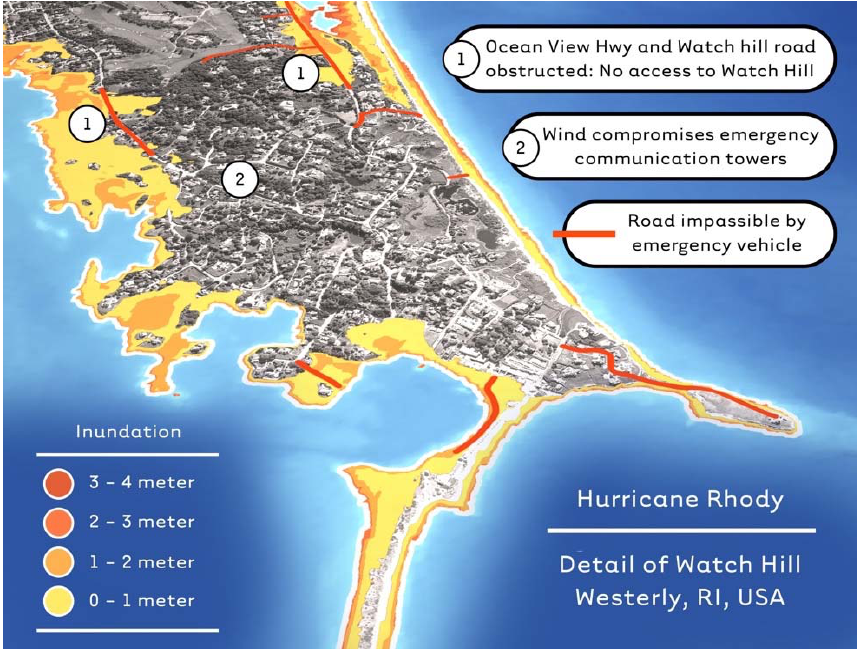
Figure 16. A detail of triggered events including analysis of roads for ambulance passage and concerns qualitatively reported by facility and emergency managers. Image: